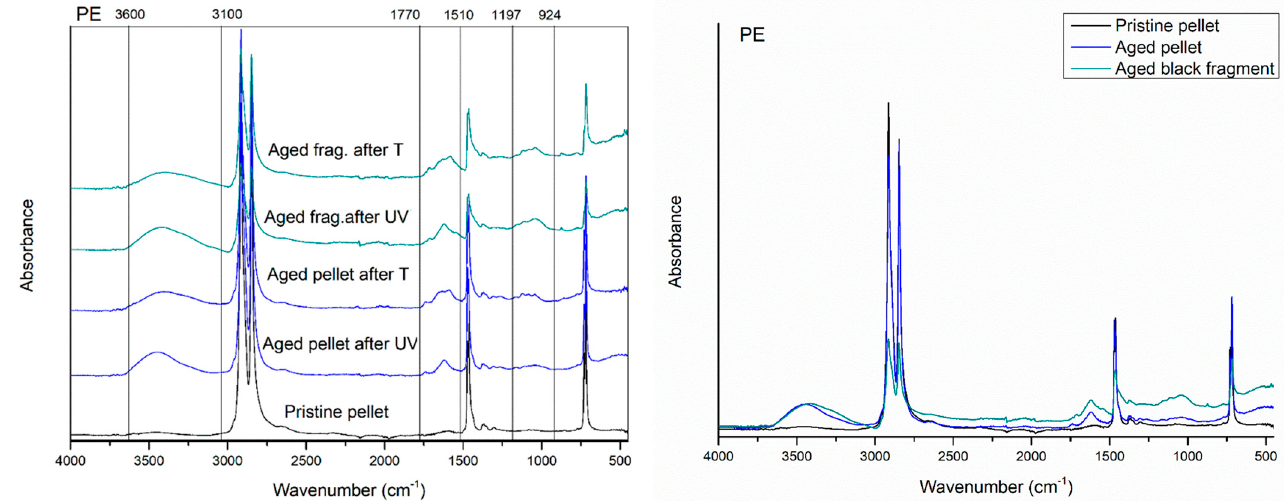
Figure 1. Comparison between the spectrum of the PE pristine pellet (black line), aged pellet (blue line), and aged black fragment (green line), after 20 days of photo-oxidation and 25 of thermos ageing in controlled conditions.